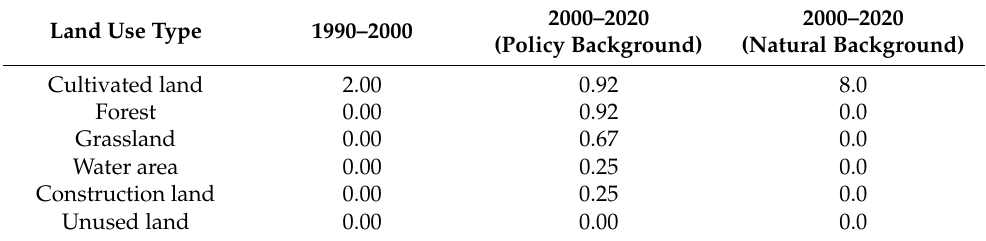
Table 7. Betweenness centrality of land use changes in different periods.